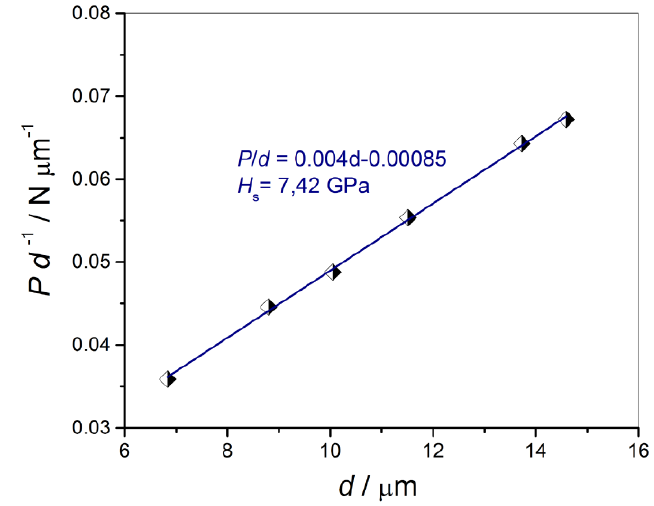
Figure 9. Proportional Specimen Resistance (PSR) plot of applied load through indent diagonal size, / d , versus indent size, d , for the Si / Cr / Au P/d , versus indent size, d , for the Si/Cr/Au substrate. P